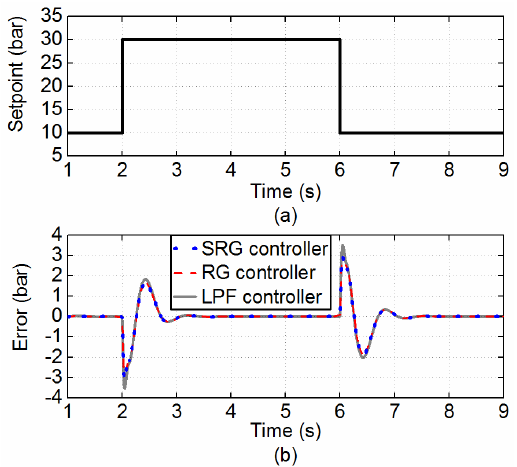
Figure 5. Tracking performance for a step trajectory from 10 bar to 30 bar. (a) The pressure trajectory. (b) The tracking error of the three controllers.